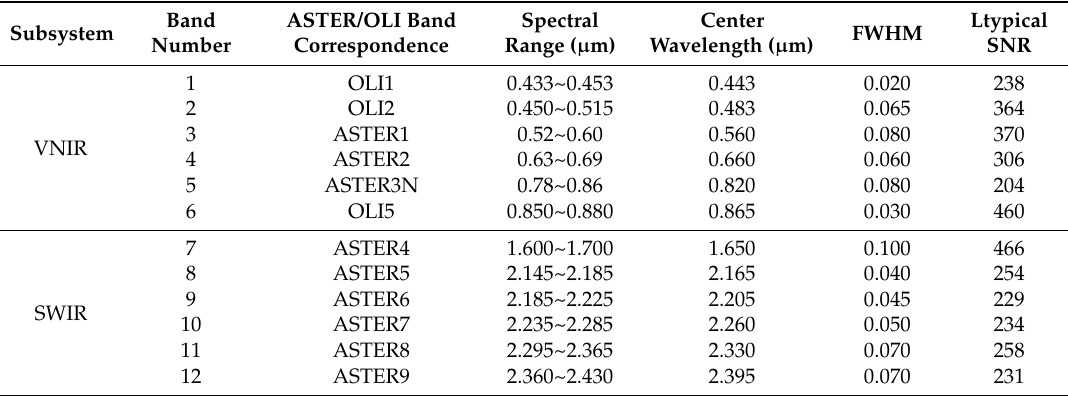
Table 2. Characteristics of the ASTER+OLI (AO)